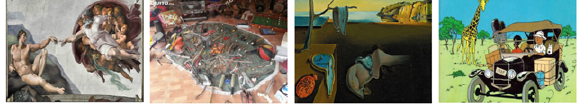
Figure 13: Examples of test images that represent new environ-